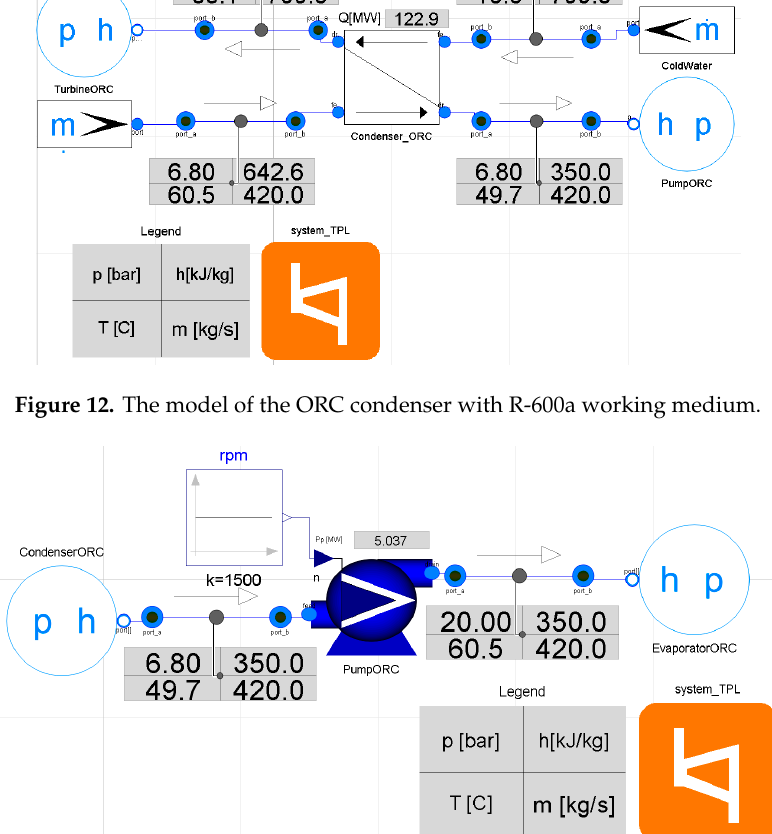
Figure 12. The model of the ORC condenser with R-600a working medium.